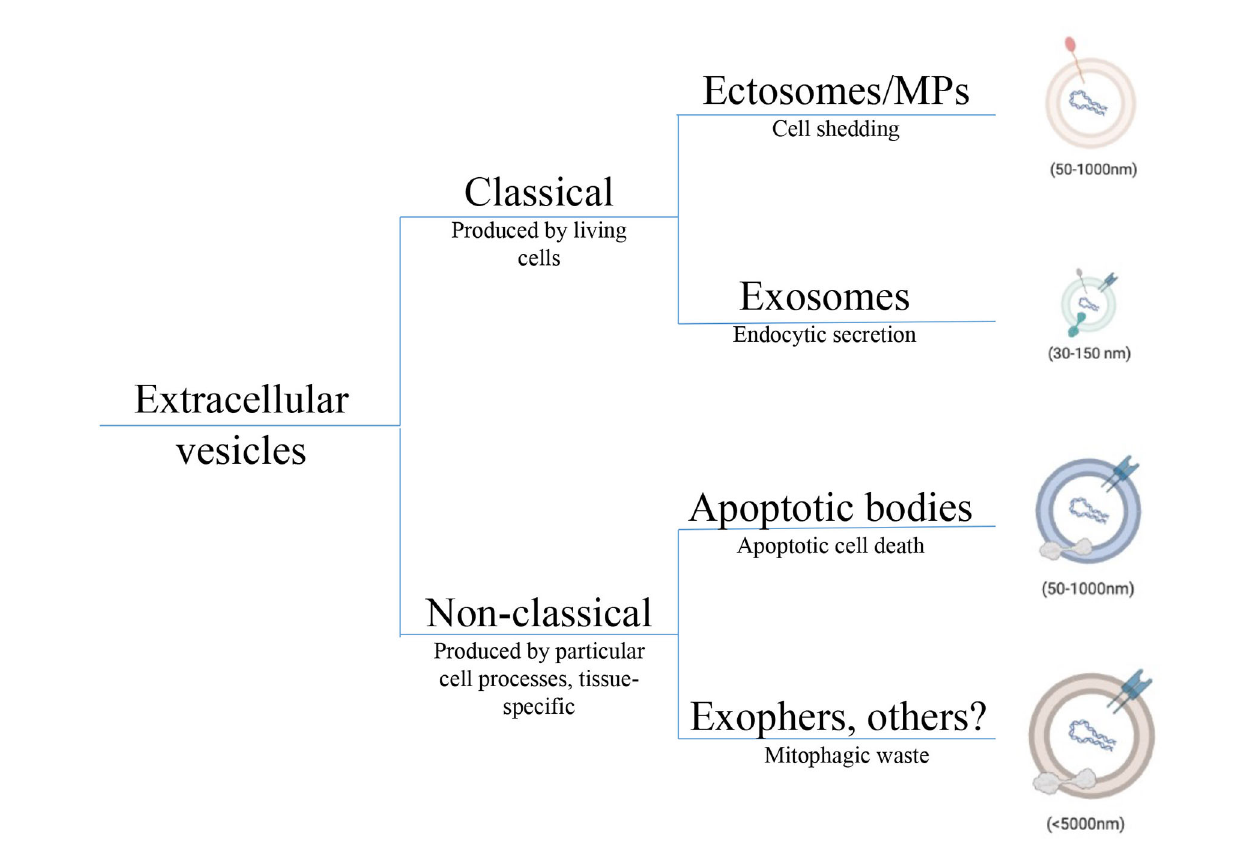
FIGURE 1 | Taxonomic tree depicting EV heterogeneity. Diversity in EV populations can be grouped into classical and non-classical subtypes. Classical EVs are produced by health living cells; either shed from the cell surface as ectosomes, also called microparticles, or derived from inside the cell as exosomes. Although exosomes and ectosomes carry similar cargos including proteins, lipids, and nucleic acids, species of endocytic origin (e.g., HSPs, mtDNA) are only expected in exosomes. Non-classical EVs tend to be larger and correspond to a wide array of cell processes and include species like apoptotic bodies from dying cells, exophers released from neurons and cardiomyocytes as metabolic waste, and oncosomes derived from certain tumor cells. Non-classical subtyping allows for a better understanding of novel EVs that do not fi t classical criteria preventing their misclassi fi cation. Cargos in each non-classical EV subtype are distinct but not fully understood. EV, Extracellular vesicle; HSP, Heat shock protein; mtDNA, Mitochondrial